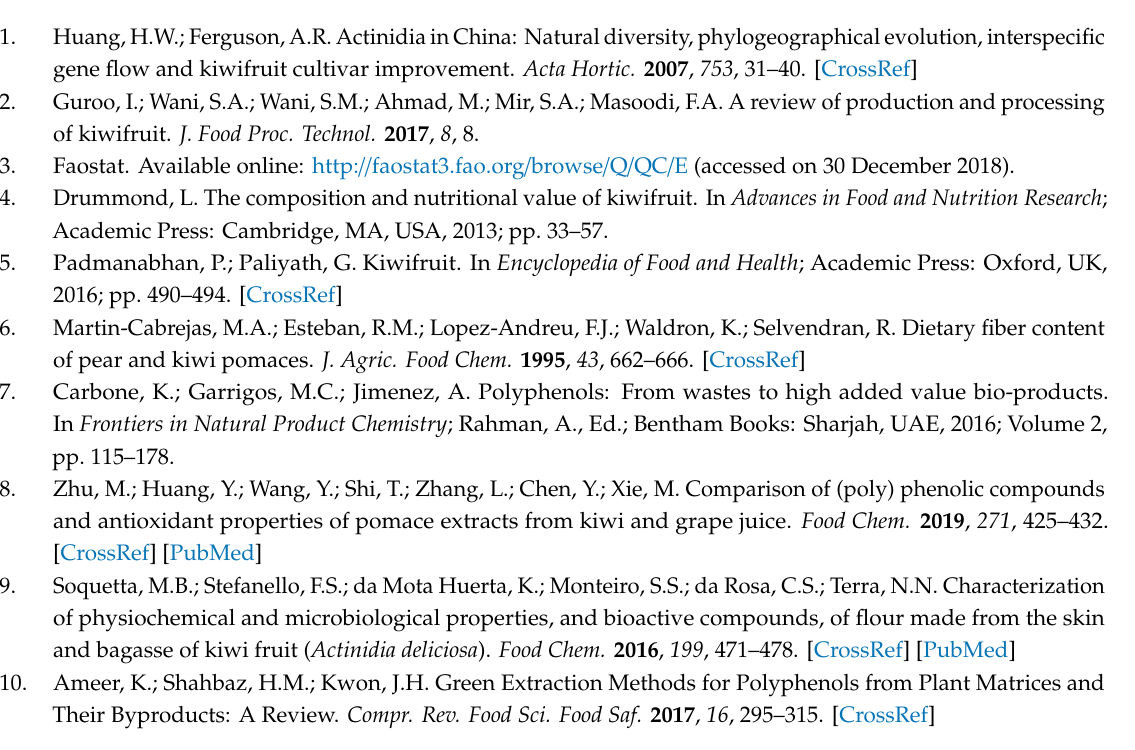
Table S1: Parameters of the ANN